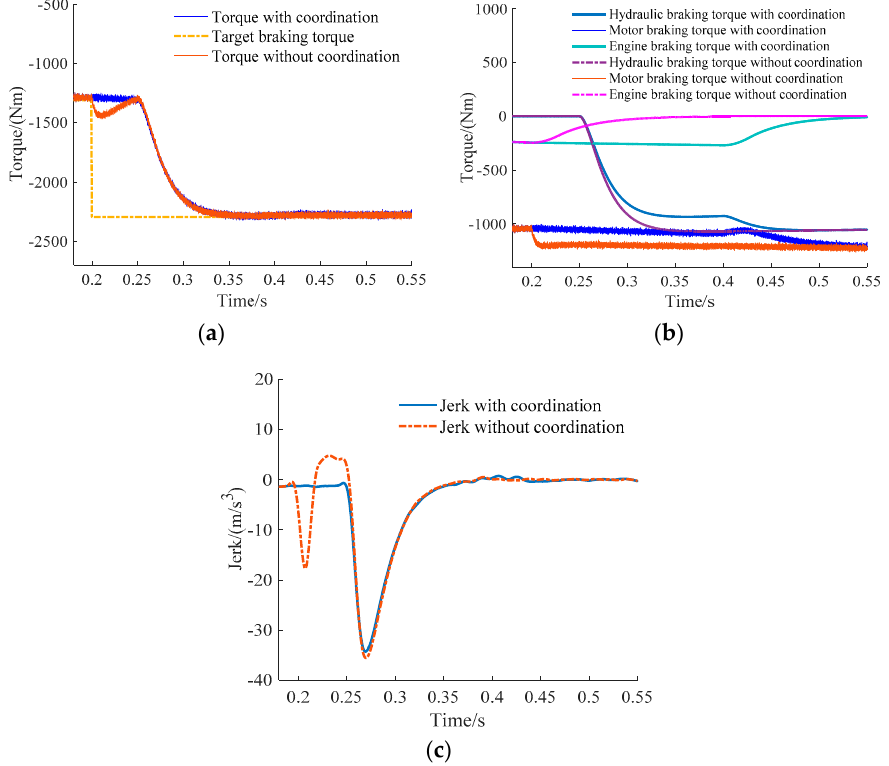
Figure 14. Simulation results of motor and engine braking mode to motor and hydraulic braking mode. ( a ) Total braking torque; ( b ) Motor, engine and hydraulic braking torque; ( c ) Vehicle jerk .